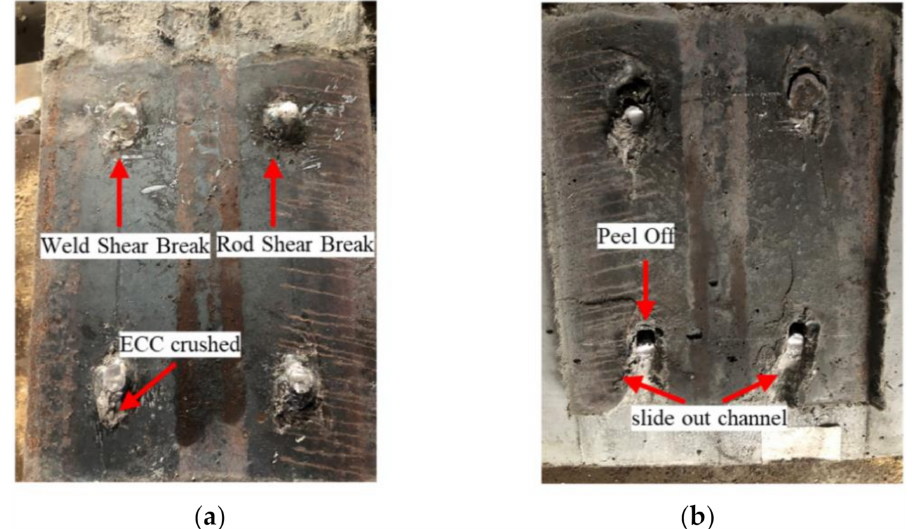
Figure 5. The damage of the specimen: ( a ) Steel plate surface; ( b ) ECC